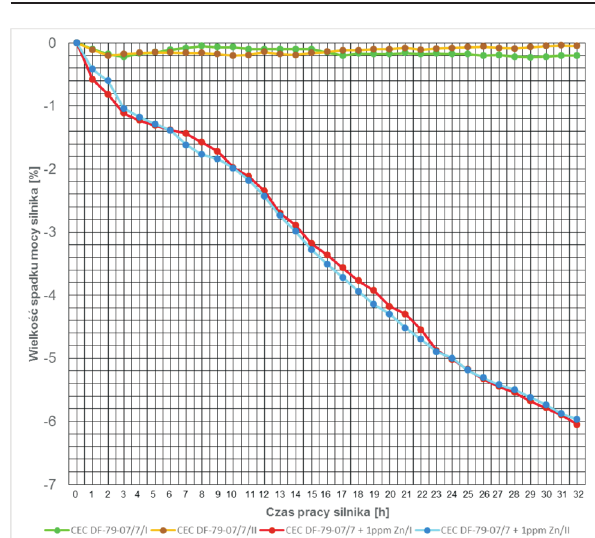
Fig. 8. Comparison of the changes in the power output of the PSA DW10 engine for fuels with and without 1 mg/kg Zn Rys. 8. Zmiany wielkości mocy maksymalnej silnika PSA DW10 podczas testów paliwa bez zawartości i z zawartością 1 mg/kg